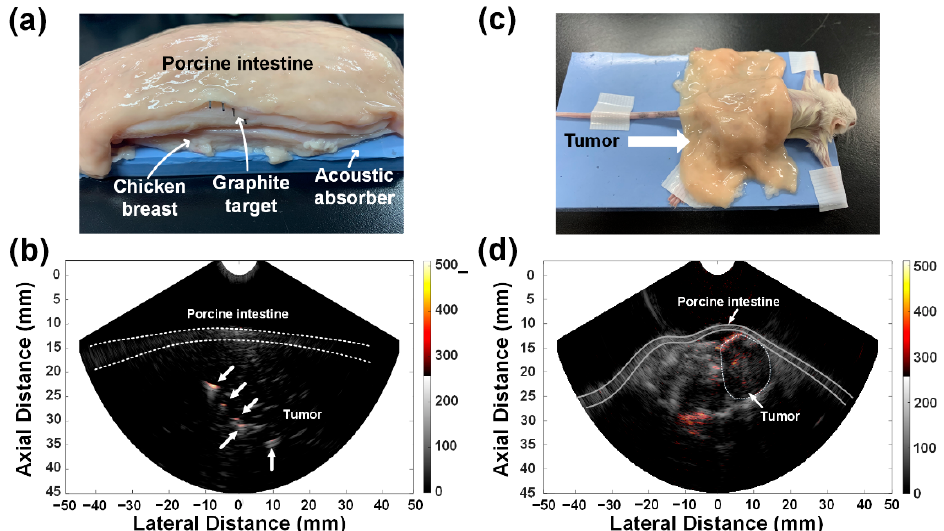
Figure 11. ( a ) Photograph of the imaging target used for the ex vivo experiments and ( b ) combined US and PA image of the five graphite rods in the chicken breast tissue covered by the porcine intestine. The US and PA images were logarithmically compressed with a dynamic range of 55 and 25 dB, respectively. ( c ) Photograph of the xenograft BALB/c (Albino, Immunodeficient Inbred Strain) mouse covered by the porcine intestine for the in vivo experiments and ( d ) combined US and PA images of the tumor site on the mouse. The US and PA images were logarithmically compressed with dynamic ranges of 45 and 25 dB, respectively.